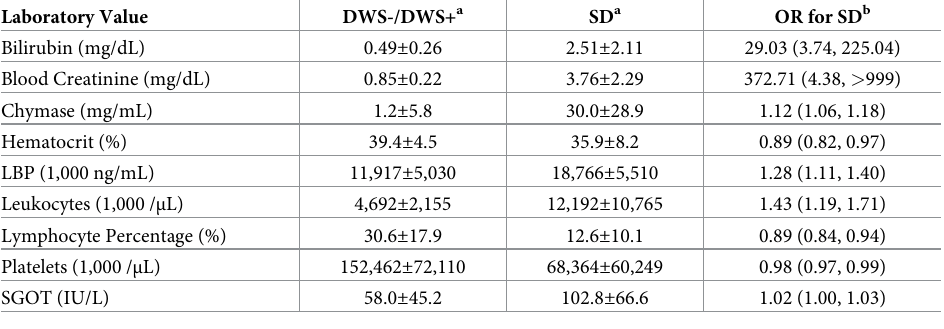
a Displayed as mean ± standard deviation b Presented as odds ratio for SD (95% CI) vs. DWS-/DWS+